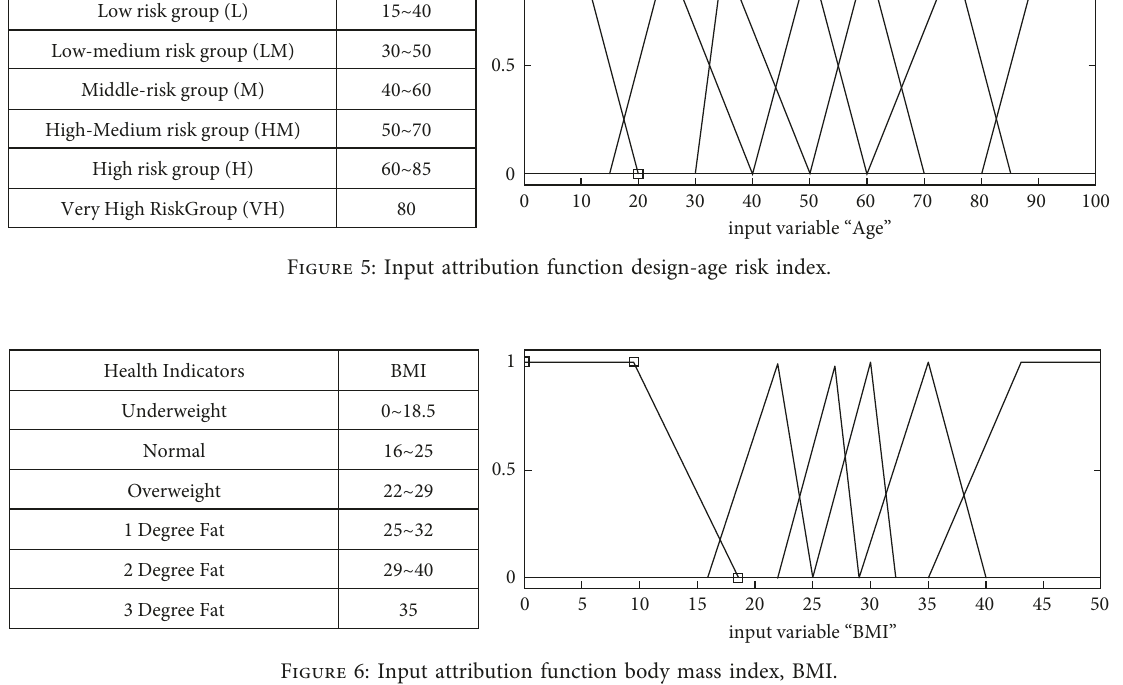
Figure 6: Input attribution function body mass index, BMI.